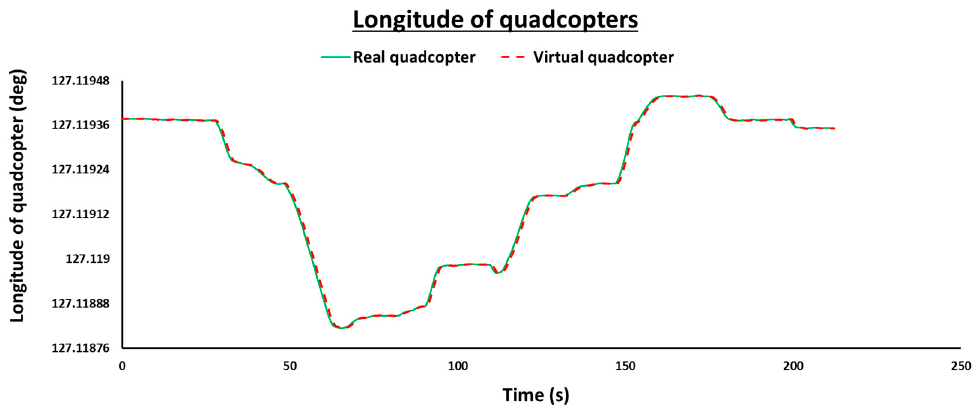
Figure 22. Longitude comparison of the real and the virtual quadcopters.